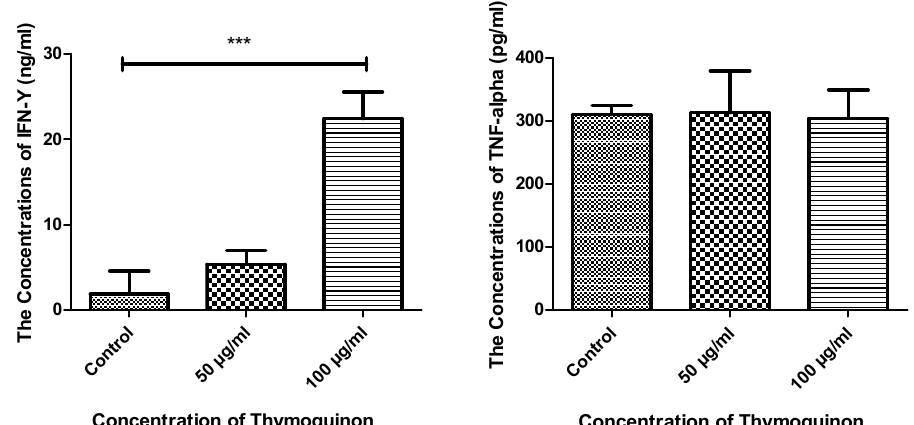
Figure 7. Comparison of the concentrations of IFN- γ and TNF- α secreted from macrophages in the three groups. The concentrations of both IFN- γ and TNF- α were detected in the different culture conditions as control, 50 µ g/mL TQ-treated and 100 µ g/mL TQ-treated cells. There was a significant difference in the concentration of IFN- γ secreted from the 100 µ g/mL TQ-treated macrophages compared to control ( p < 0.0001), while no changes were detected for TNF- α . n = 5. IFN- γ , interferon gamma; TNF- α , tumour necrosis factor alpha. *** p value ≤ 0.001.